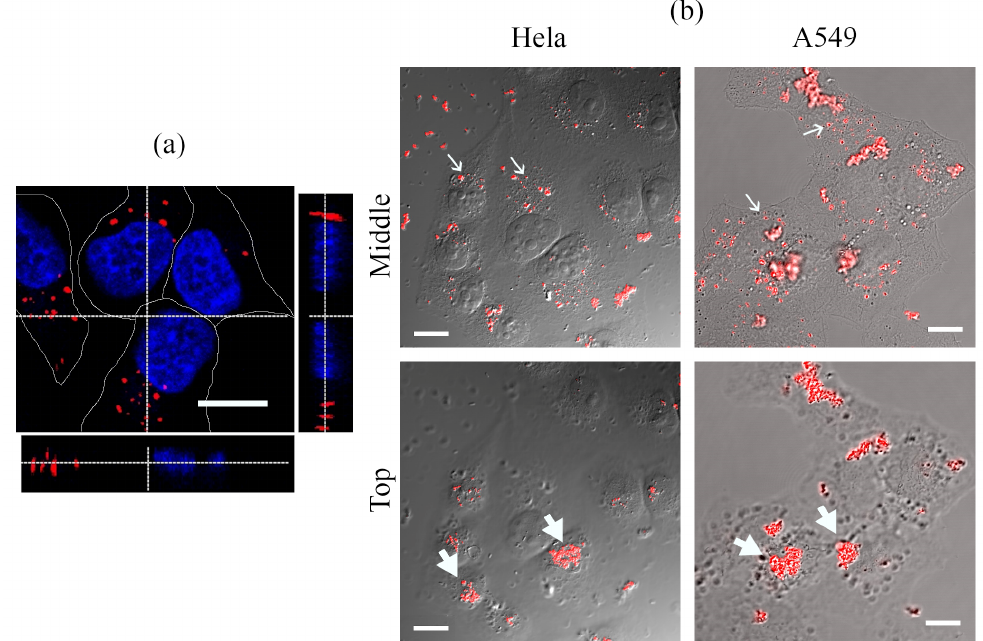
Figure 3. Confocal images of cells after incubation with QDs (50 nM) for 24 h. ( a ) Optical slice of HeLa cells at the nucleus level (red channel—QDs, blue channel—Hoechst 33342); below and on the right, there are orthogonal sections of cells obtained as a result of scanning along the XZ and YZ axes. ( b ) Overlay of DIC images of cells and the QD luminescence channel. Localization of QDs is represented by optical sections taken from Z-series at the level of the nucleus ( middle ) and just above the apical surface ( top ) of HeLa and A549 cells. Thin arrows show examples of QDs inside cells; thick arrows indicate of QDs association with the cell surface outside the cell. Photoluminescence of QDs excited at 405 nm and recorded in the range of 520–620 nm. Hoechst 33342 fluorescence was excited at 405 nm and recorded in the range of 430–480 nm. Scale bars 15 µ